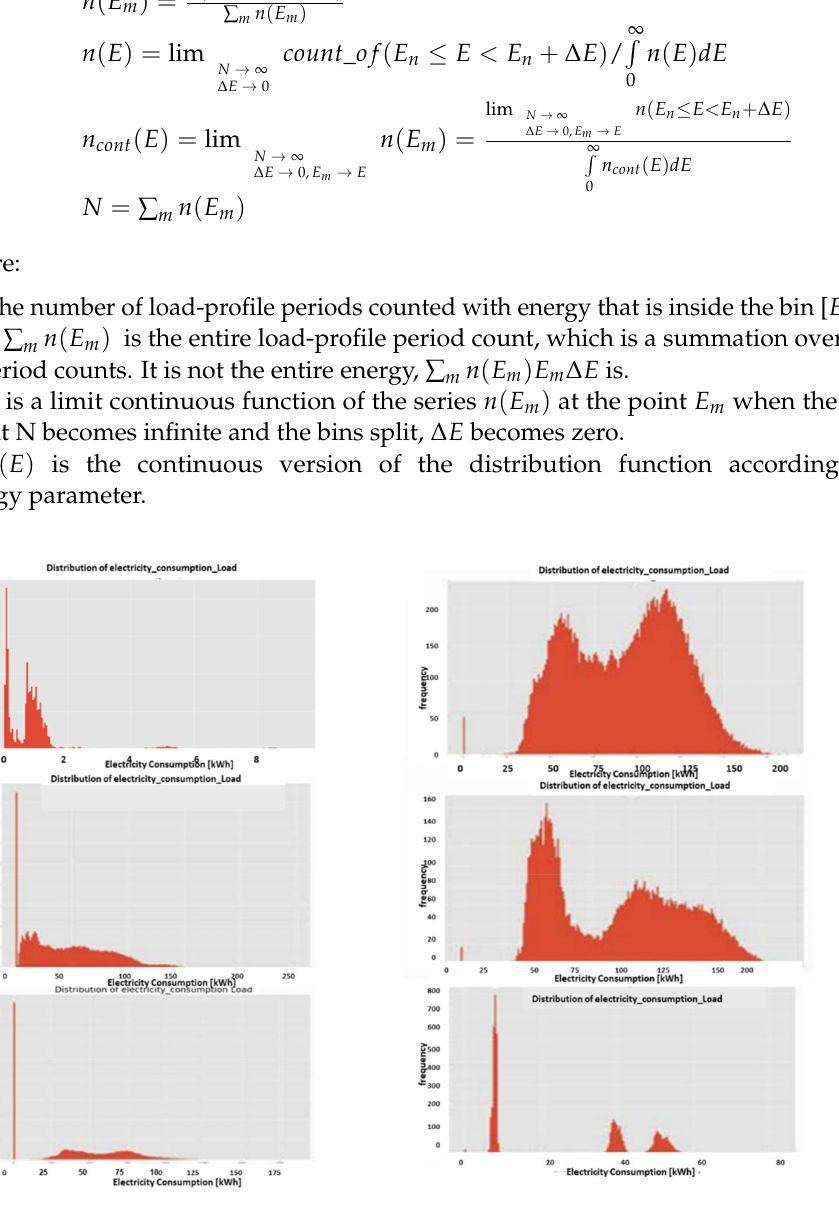
Figure 9. Four verified fraud test cases (two left columns) versus three verified non-fraud test cases. Fraud indicates technical/nontechnical. Technical loss type differentiation is